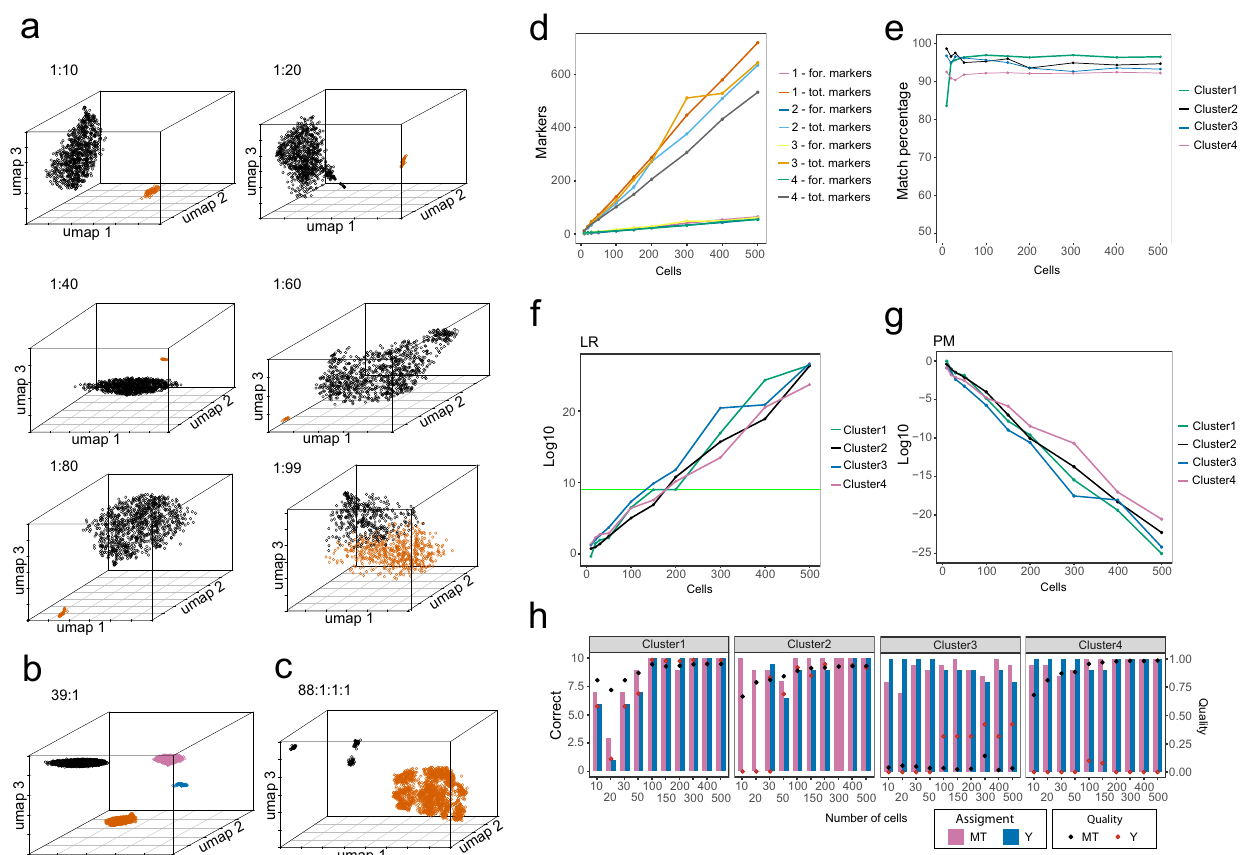
Fig. 5 Analysis of imbalanced mixtures and testing of cell number limits in mixture deconvolution with subsequent genetic characterisation and individual genetic identi fi cation of the mixture contributors via de-goulash analysis of single-cell transcriptome sequencing data. a UMAP clustering showing the limitation of the single-cell separation process in imbalanced 2-person mixtures of various mixture ratios from 1:10 to 1:99. b , c UMAP clustering from single-cell mixture deconvolution of imbalanced 4-person mixtures with minor component of 3% of the total cell counts, b mixture with one minor component (blue), c mixture with three minor components (black). d Average number of identity SNPs used for individual identi fi cation (for. markers) and total number of available SNPs (tot. markers) per cluster per number of cells of deconvoluted and sampled cluster of mixture of four individuals (dataset M4). e Percentage of identity SNP alleles matching between cell cluster and WES reference database per cell cluster per number of cells (from deconvoluted clusters of dataset M4). f Average logarithmic expression of likelihood ratios per cell cluster per number of cells (from deconvoluted clusters of dataset M4). g Average logarithmic expression of match probability per cell cluster per number of cells (from deconvoluted clusters of dataset M4). h Average correct assignment of Y and mtDNA haplogroups per cell cluster from deconvoluted clusters of dataset M4 (bars) with marked average quality of the prediction (as